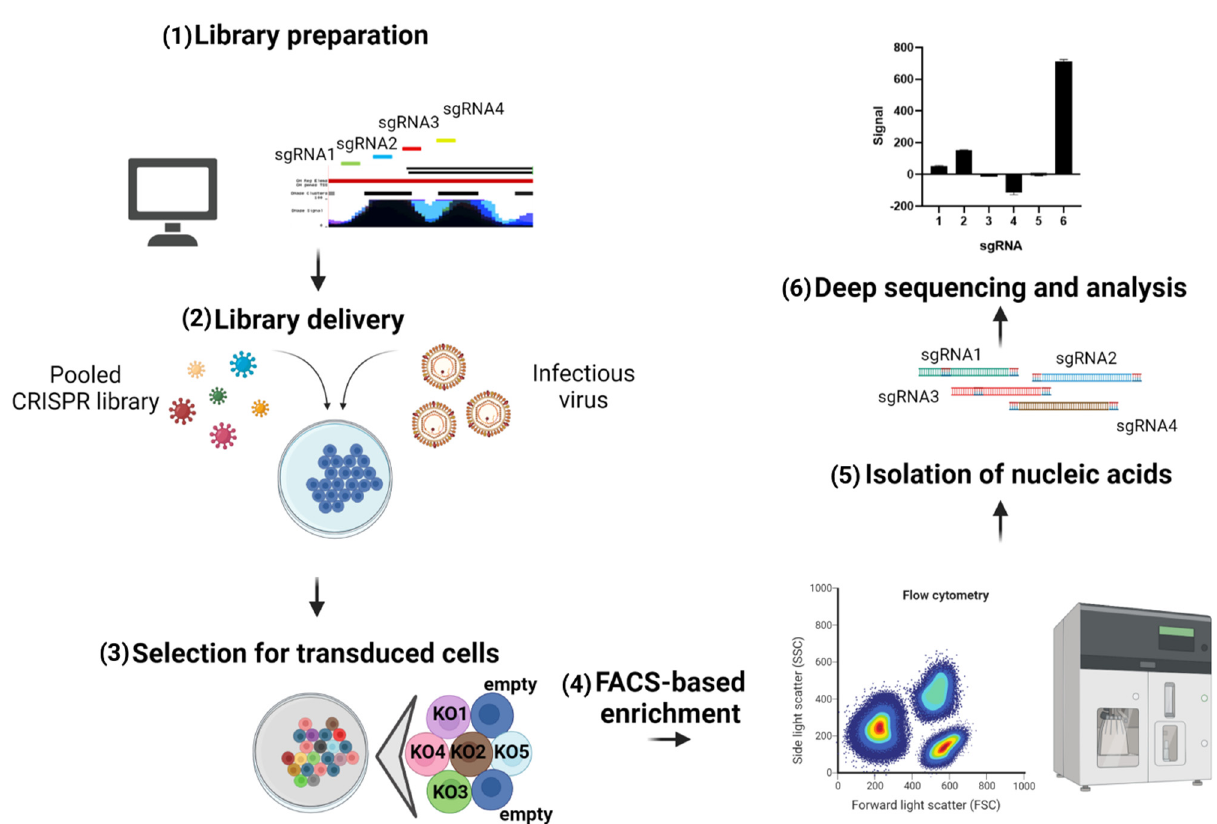
Figure 4. General pipeline of pooled CRISPR screens. ( 1 ) In silico design of sgRNA targeting regulatory elements (promoters and/or enhancers) of target genes (or in genome-wide format). In modern pooled libraries, four to 10 different sgRNAs are designed to target a single regulatory element, which constitutes up to 200,000 sgRNAs in a single genome-wide library. ( 2 ) Lentiviral delivery of CRISPR pooled library into cells expressing appropriate Cas protein (Cas9 for knockout screens and dCas9 for activation of interference screens) into infected cells at low MOI (to ensure delivery of a single sgRNA into a single cell). ( 3 ) Selection of transduced cells (negative or positive). Note that knockdown of genes (KO) is relevant for nucleolytic Cas systems and base editors, whereas CRISPRa and CRISPRi systems cause the overexpression or suppression of gene transcription, correspondingly. ( 4 ) Enrichment of cells. ( 5 ) Isolation of nucleic acids from the bulk of enriched cells. ( 6 ) Deep sequencing and identification of hits by determining sgRNAs representation in the material. This picture was created in BioRender.